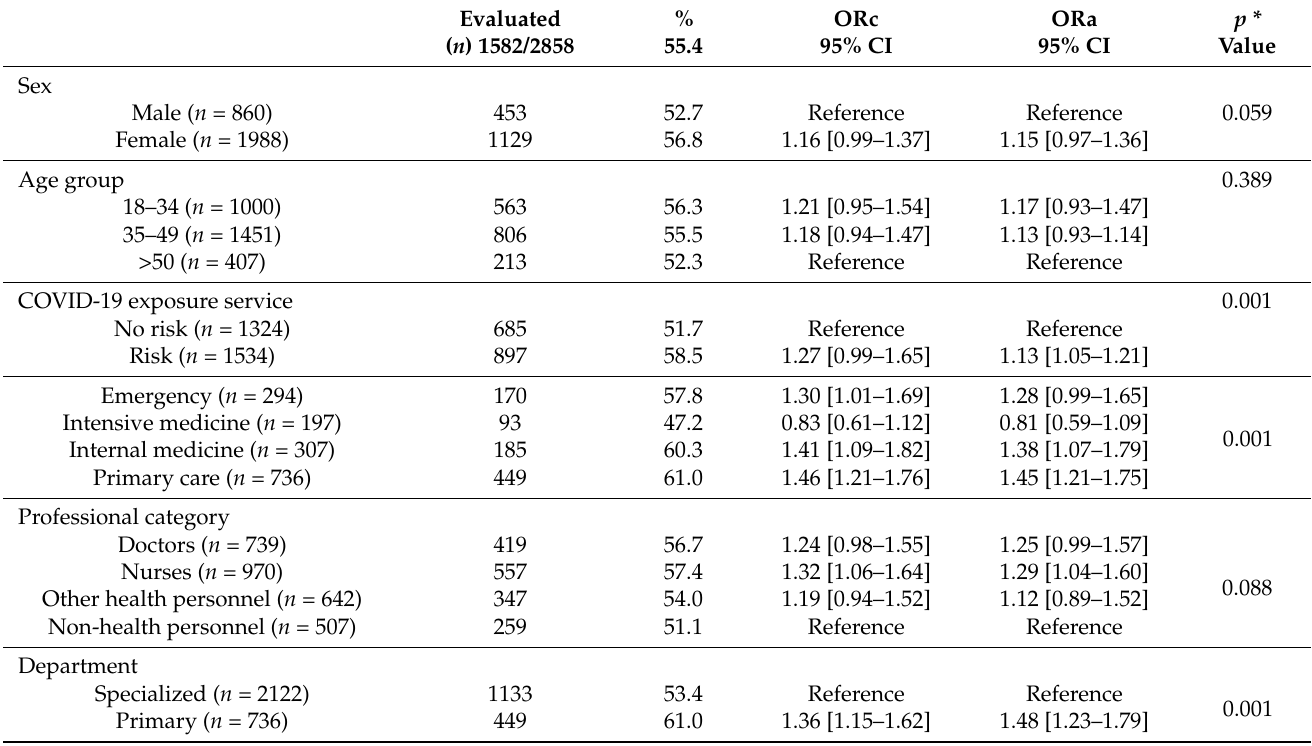
Table 2. Requests for the diagnostic test of active infection (AIDT) for SARS-CoV-2 in the health professionals of the Elche-Crevillente and Torrevieja health